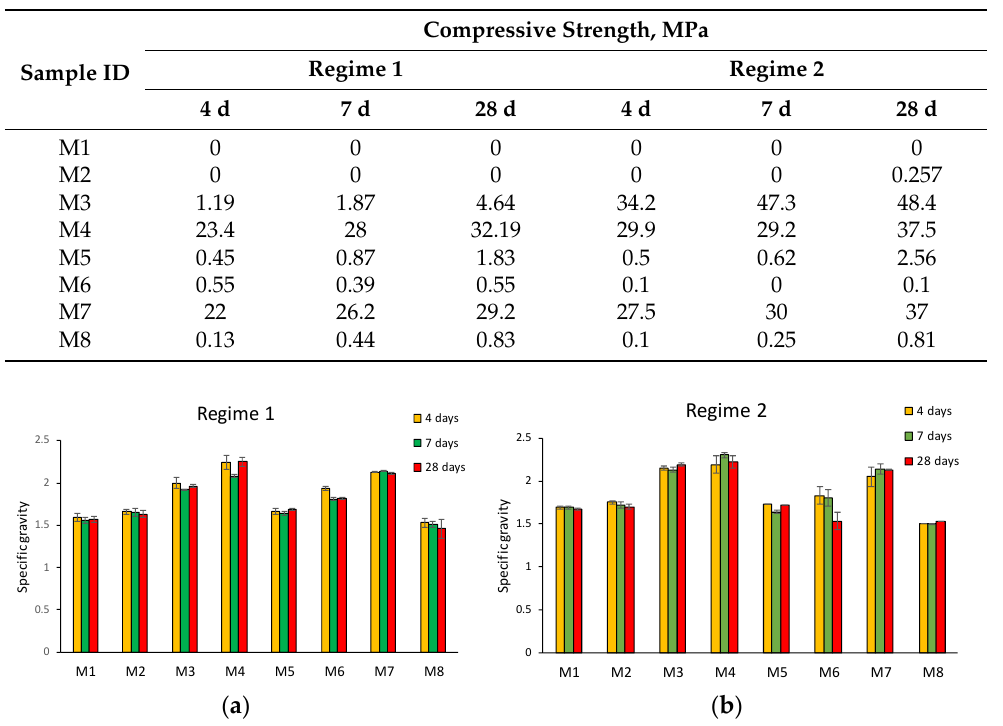
Table 1. Compressive strength of AAC mixes cured in different regimes.